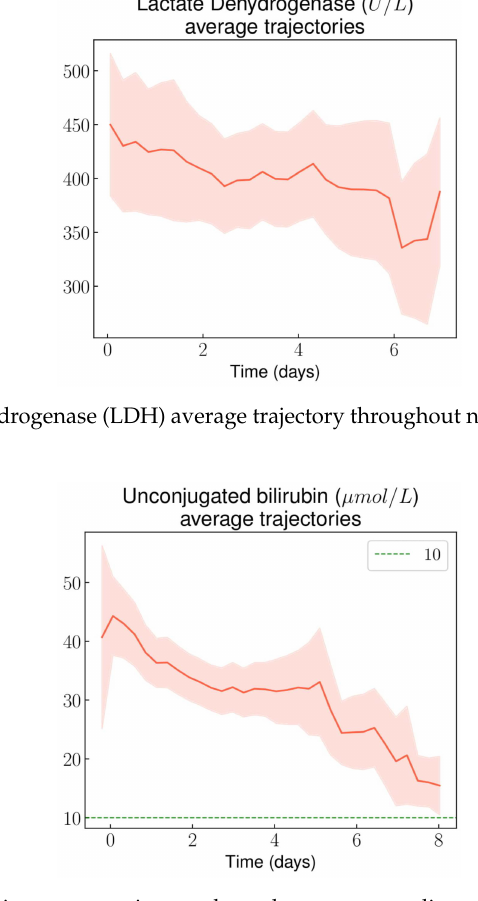
Figure A8. Direct bilirubin average trajectory throughout non-complicated VOC-related hospital